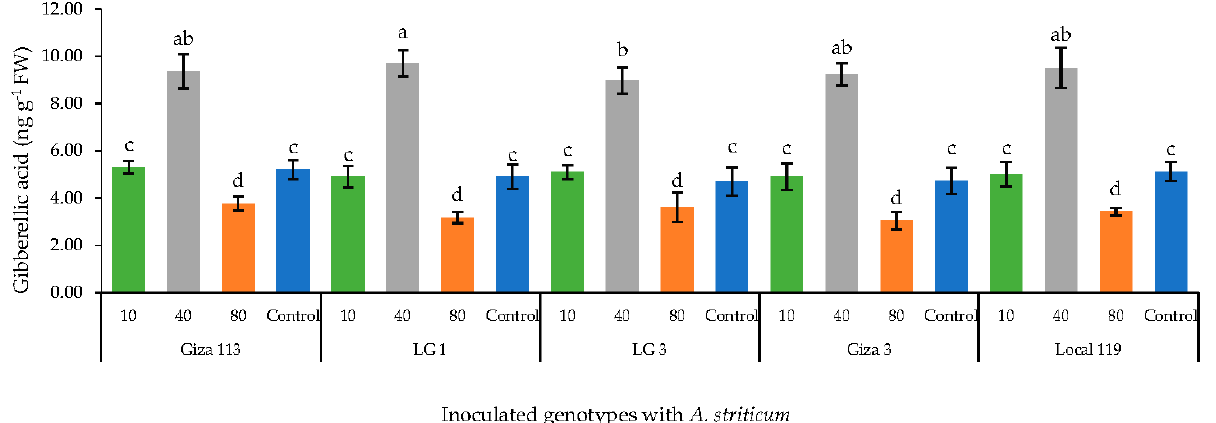
A concentration of 40 mg L − 1 of Fe 3 O 4 /HA NPs led to a significant ( p < 0.05) increase in the level of gibberellic acid (GA3) in five sorghum genotypes. In contrast, the concen- tration of 80 mg L − 1 significantly ( p < 0.05) downregulated the level of GA3 in all the genotypes when compared to the control and the lowest concentration of 10 mg L − 1 . GA3 levels remained unaffected by the lowest concentration, 10 mg L − 1 , and were comparable to untreated control plants (Figure 3).